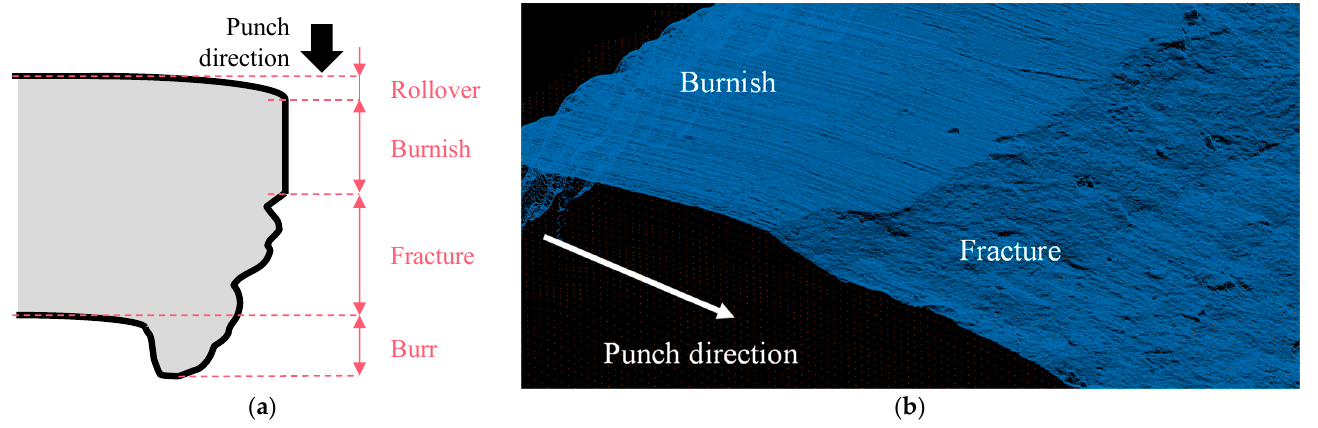
Figure 1. Classification of edge geometry in ( a ) schematic illustration and ( b ) 3D microscopy.